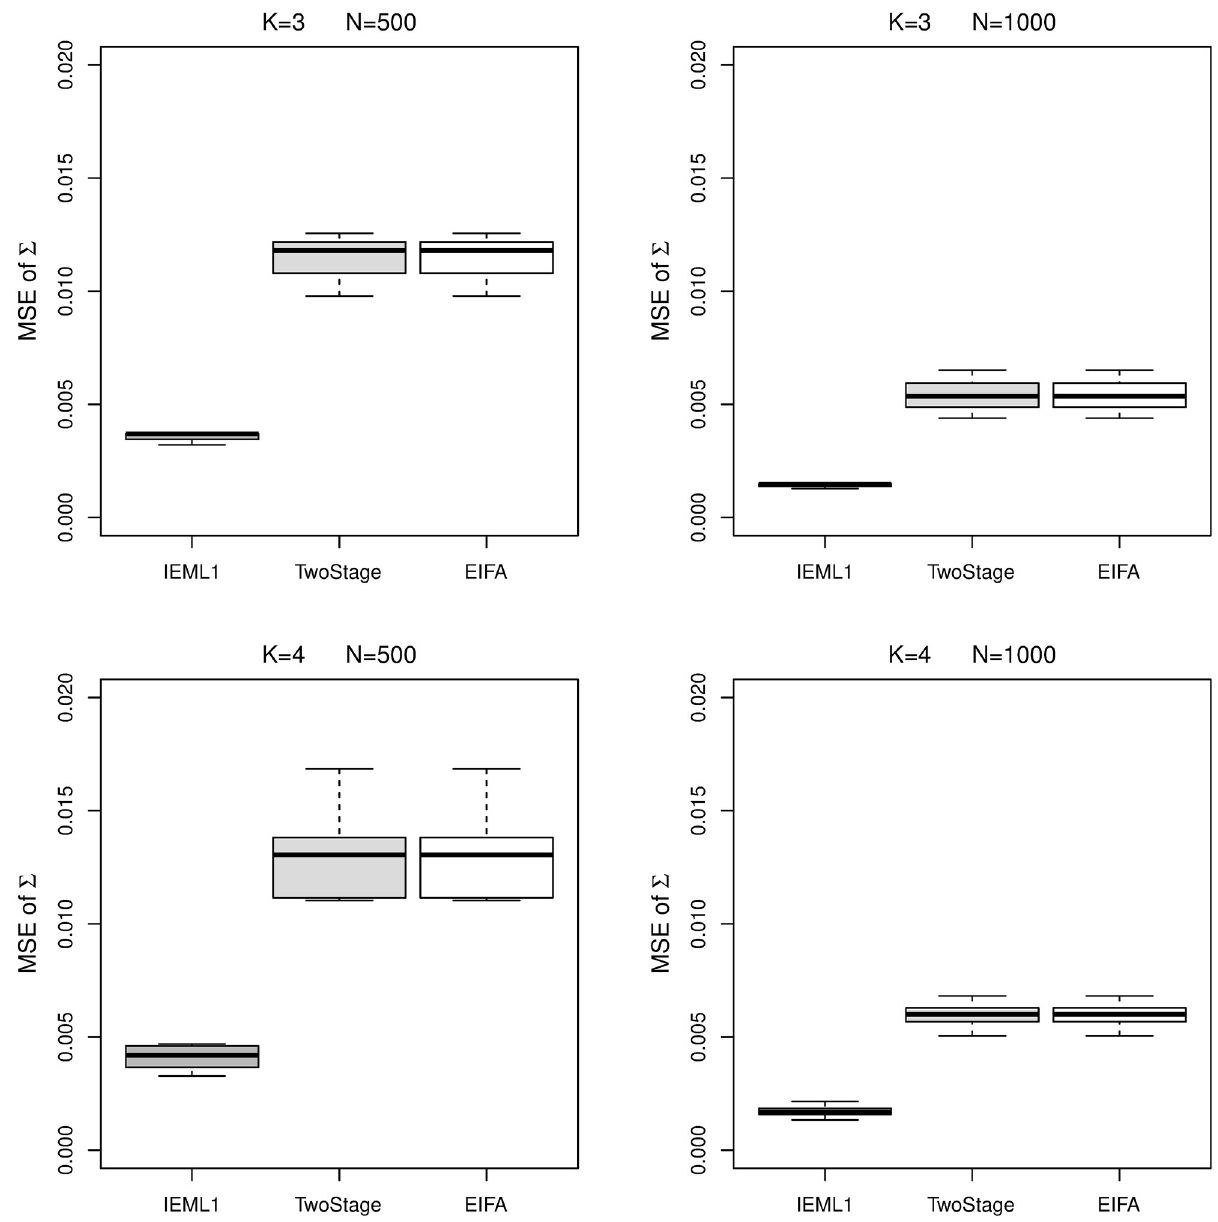
Fig 6. Boxplots of the MSE of S obtained by IEML1 (dark gray boxes), two-stage (light gray boxes), EIFAthr and EIFAopt (white boxes) for K = 3 and 4 under sample size N = 500 and 1000.